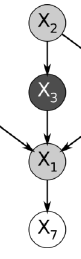
Figure 1. The Markov boundary of variable X 3 emphasised with light gray in a simple Bayesian